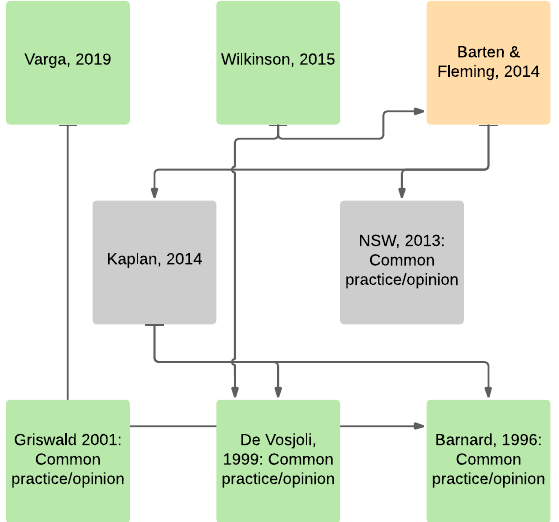
Figure 2. Peer-reviewed evidence-base showing primary cross-referencing of sources for recommended minimum snake enclosure dimensions derived from Table 4 and consistent with <1 × SL. Arrows direct to previously published material. Green boxes = peer-reviewed citations in Table 4 that specifically relate to enclosure sizes for snakes. Amber boxes = citations of general biological or behavioral nature referenced as supportive information. Grey boxes = citations of grey literature sources referenced as supportive information. Cited references in Figure 2: Varga, 2019 [58]; Wilkinson, 2015 [48];